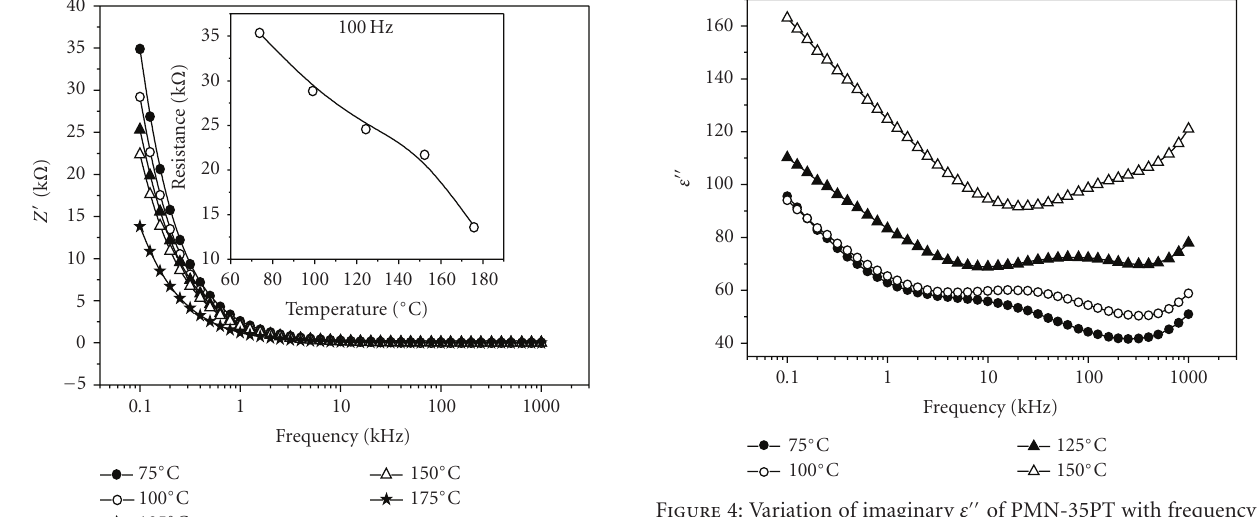
Figure 4: Variation of imaginary ε (cid:6)(cid:6) of PMN-35PT with frequency at di ff erent